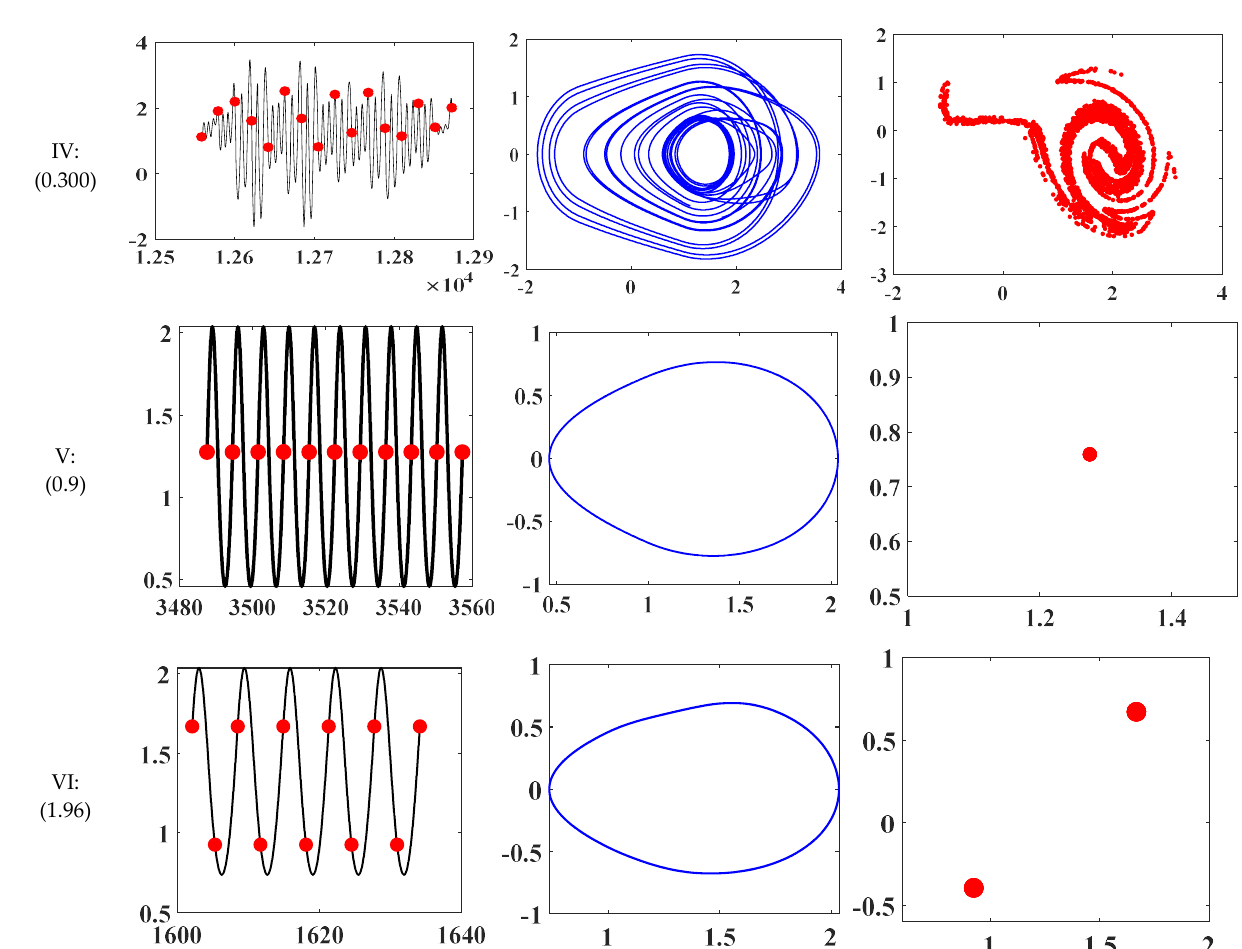
Figure 10. Nonlinear vibration behavior in different frequency ratios for backward simulation, case 1.